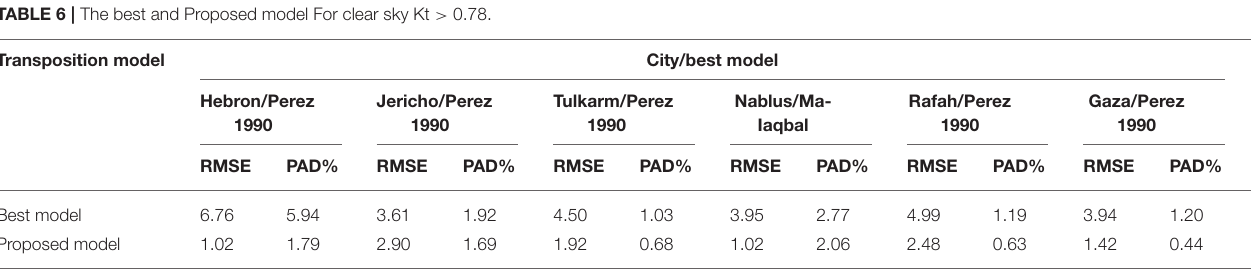
TABLE 6 | The best and Proposed model For clear sky Kt >